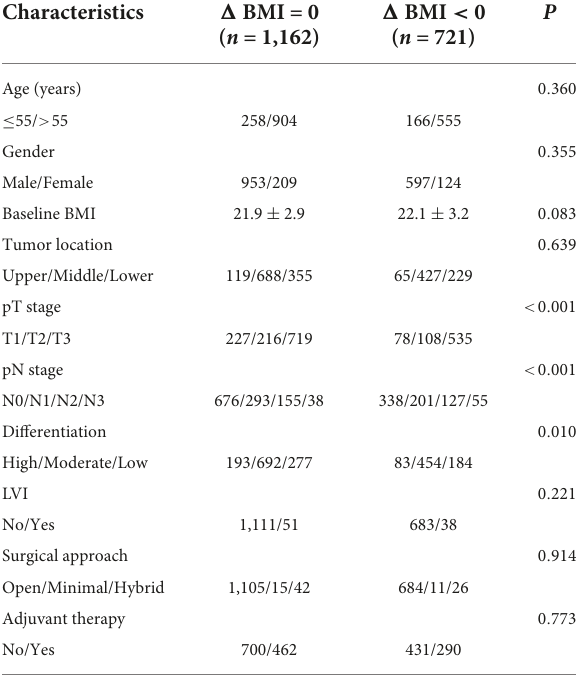
TABLE 1 Patient characteristics ( n = 1,883).